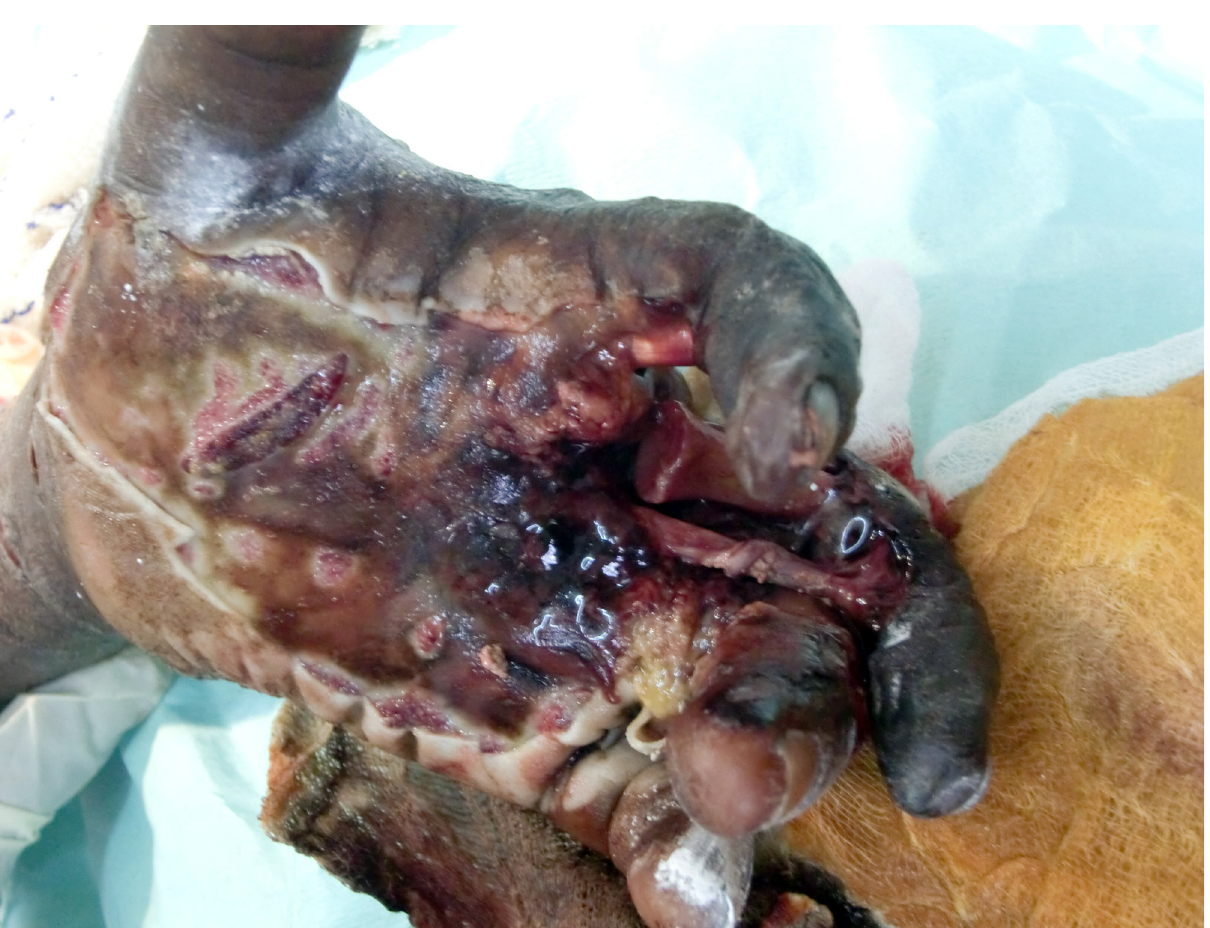
Figure 9. Necrosis